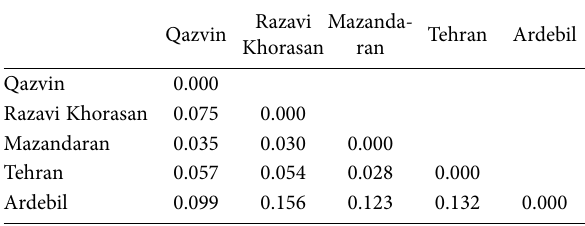
Table 6. Pair-wise analysis of Fst in the studied provinces based on ISSR data.